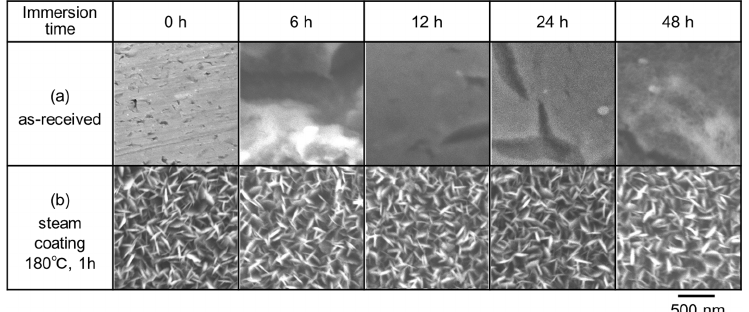
Figure 9. High ‐ magnification SEM images showing surface morphologies of ( a ) uncoated specimen and ( b ) specimen subjected to steam coating at 180 °C for 1 h, after saltwater immersion for up to 48 h.